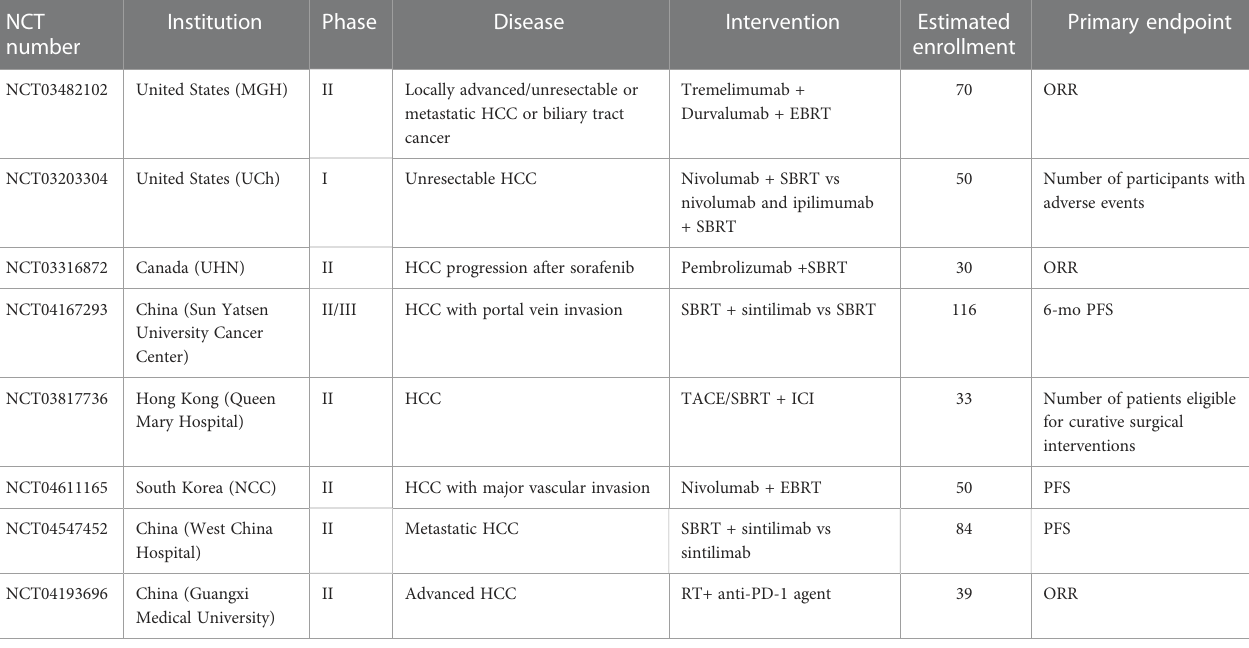
TABLE 1 On-going clinical trials for a combination of immune checkpoint inhibitors and